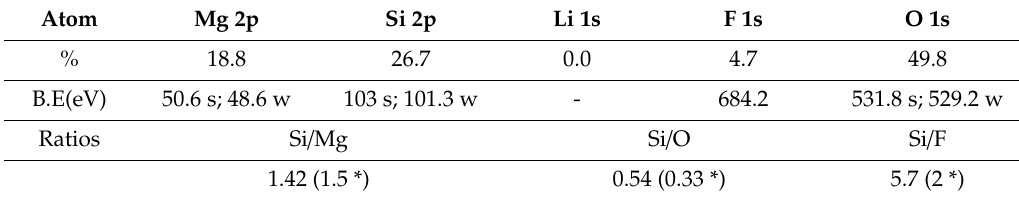
Table 3. Surface atomic concentration, binding energy and atomic ratios of elements of fluorohectorite Li-FH determined by XPS.